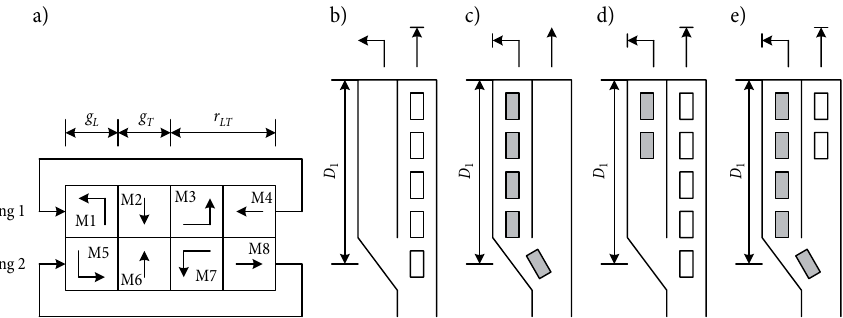
Fig. 1. Blockage and overflow of short left-turn lane under leading left-turn phasing: a – signal phase sequence; b – blockage of short left-turn lane during the green phase for the left-turn movement and red phase for the through movement; c – overflow of short left-turn lane during the green phase for the through movement and red phase for the left-turn movement; d – blockage of short left-turn lane during the red phase for both left-turn and through movements; e – overflow of short left-turn lane during the red phase for both left-turn and through movements